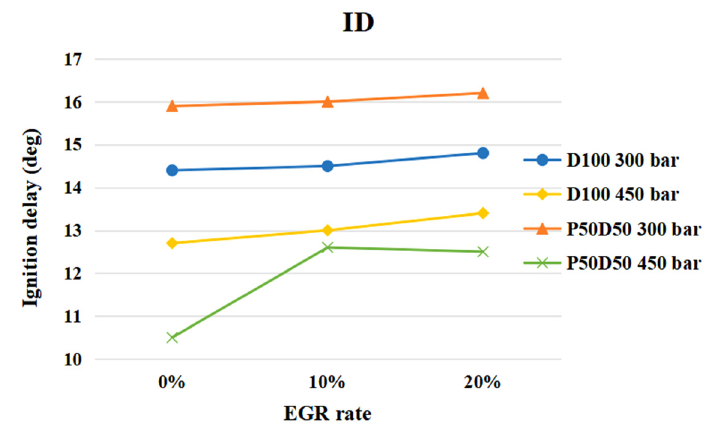
Figure 10. ID under different EGR rates at 300 and 450 bar.